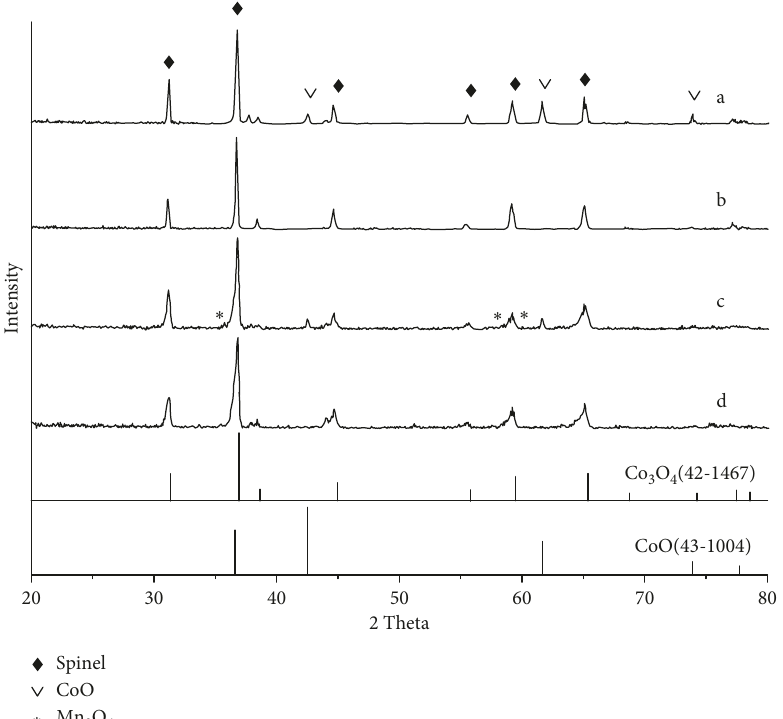
Figure 5: XRD patterns of the coatings after conversion for different times: (a) the Co coating for 10min; (b) the Co coating for 4h; (c) the Co-Mn 3 O 4 coating for 10min; and (d) the Co-Mn 3 O 4 coating for 4h. Cross-sectional examination of the converted